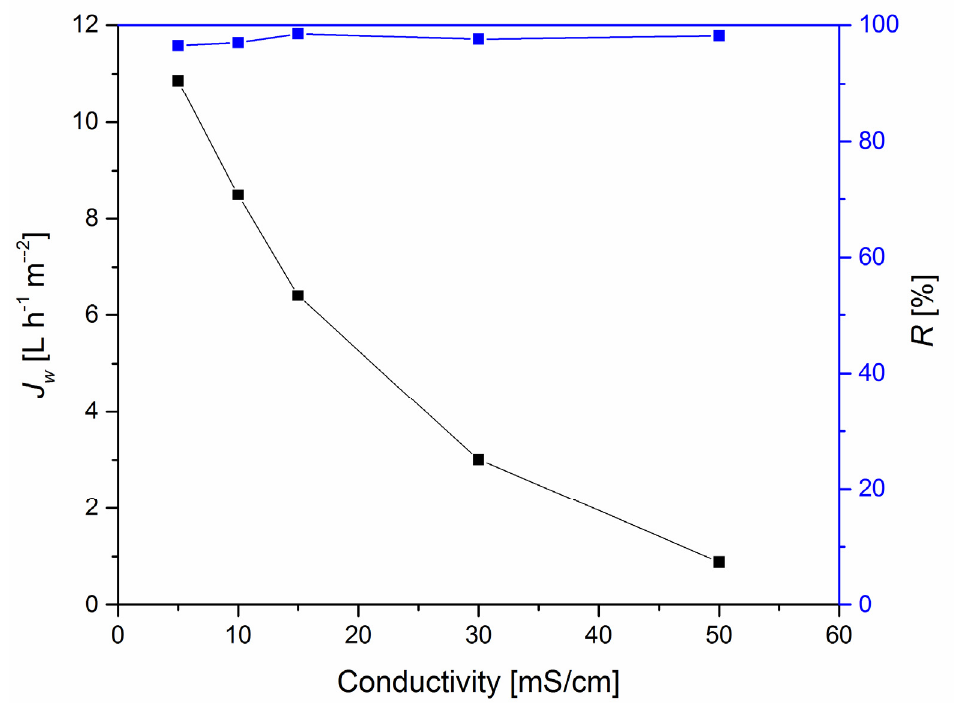
Figure 6. Water flux and rejection of mPSS solute as a function of conductivity (concentration) of mPSS solution using commercial PS35 UF membrane at 140 psig.